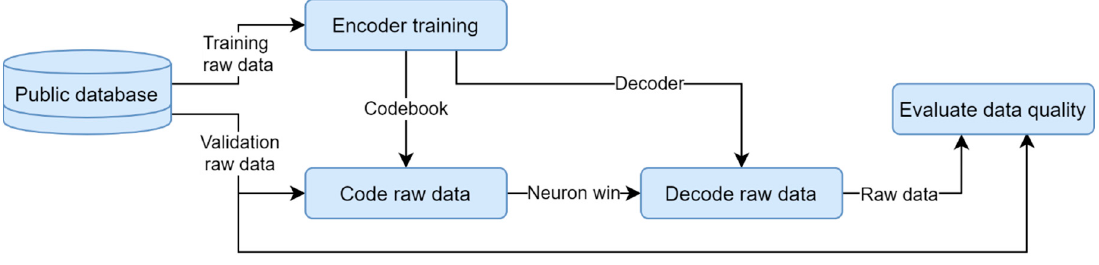
ffl ine compressor model validation. Figure 7. Offline compressor model validation. Figure 7. O